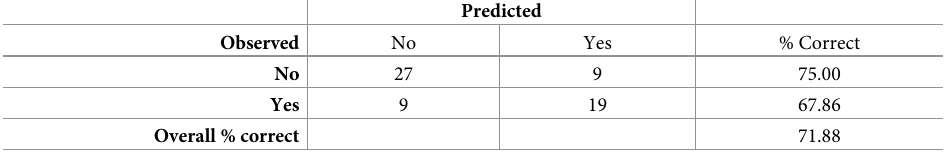
Table 5. The observed and predicted frequencies for rejection by logistic regression with cutoff of 0.50.